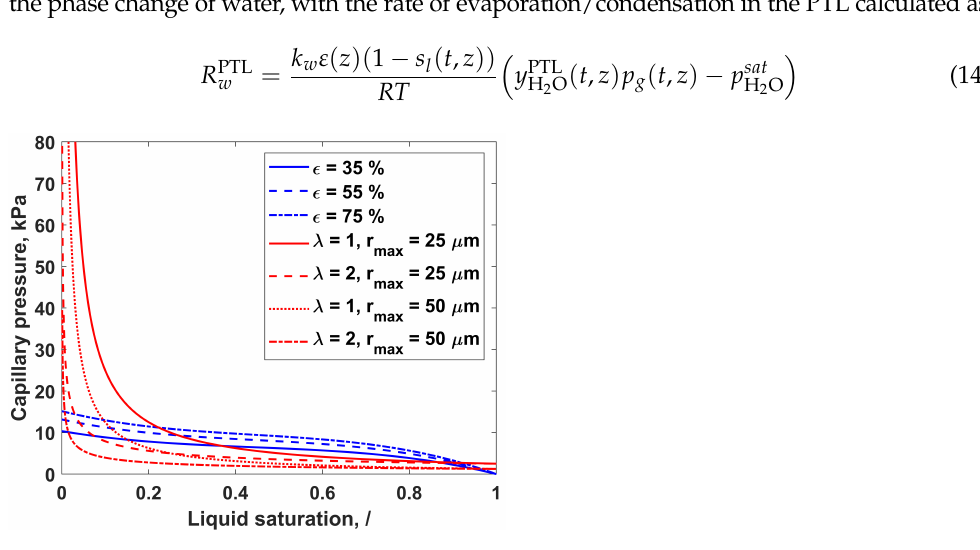
Figure 2. Capillary pressure as a function of the liquid saturation calculated with LE for different porosities, ε (blue lines) and with BCE for different PSD indices, λ (red